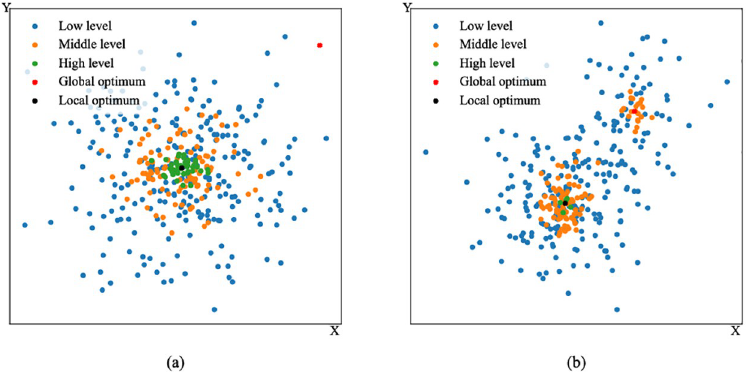
Fig 2. Competition mechanism in two-dimensional multimodal problems. The points represent the particles. (a) Particles are trapped in the local optimum. (b) Particles jump out of it.